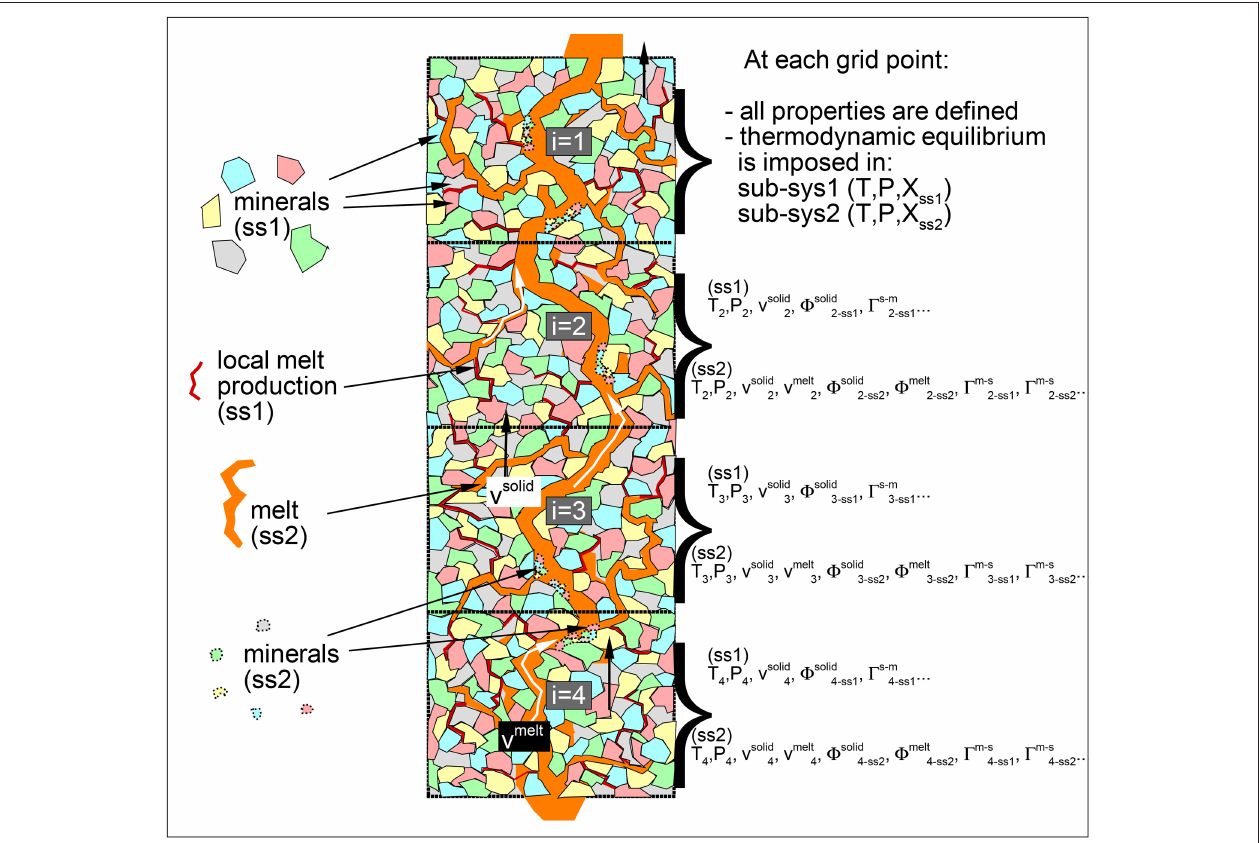
FIGURE 1 | Schematic view of the mantle melting column. In the dynamic fractional melting (DFM) model at each grid point local equilibrium is assumed separately for the residual solid and for melt in two sub-systems. Dynamic and thermodynamic properties represent the average spatial values within each sub-system. Melt formed in the first sub-system (sub-sys1) is transferred in the second sub-system (sub-sys2). Melt in sub-sys2 is allowed to crystallize but the new solid remains in sub-sys2. Distribution of melt and minerals in the figure not in scale. The illustration describes only one possible visual interpretation of the model regarding the melt and solids distribution inside the representative spatial grid points. Details about the numerical discretization and numerical solution can be found in